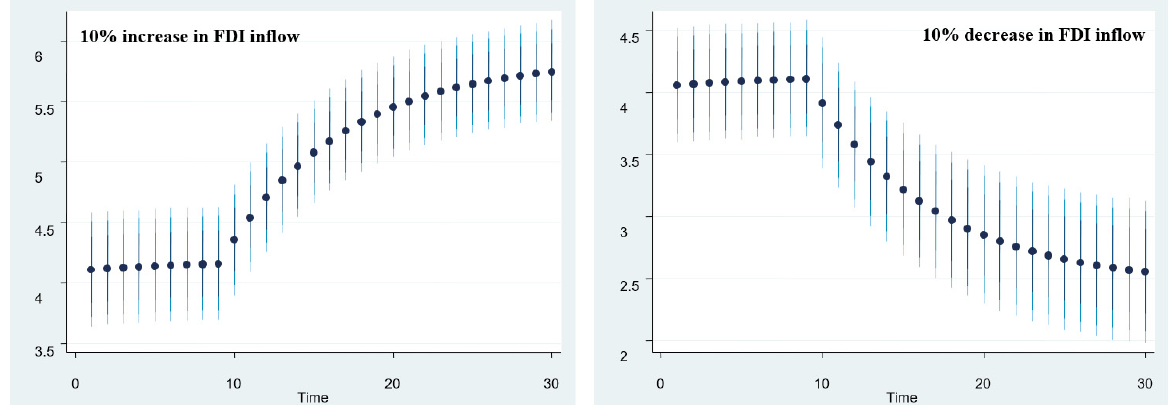
Figure 3. Inward FDI flows and domestic investment. The above graphs portray ±10% in the inward FDI flow and its impact on domestic investment. The dots depict the average prediction value, while the dark blue to light blue lines indicate 75%, 90%, and 95% confidence interval, respectively. Figure 4 illustrates a 10% positive and negative impact of the outward FDI flow on the domestic investment in Bangladesh. Both of these graphs indicate that positive and negative shocks demonstrate positive effects in the short run and in the long run. Still, the negative shock shows that the impact of the outward FDI flow decreases with adverse changes in the long run.